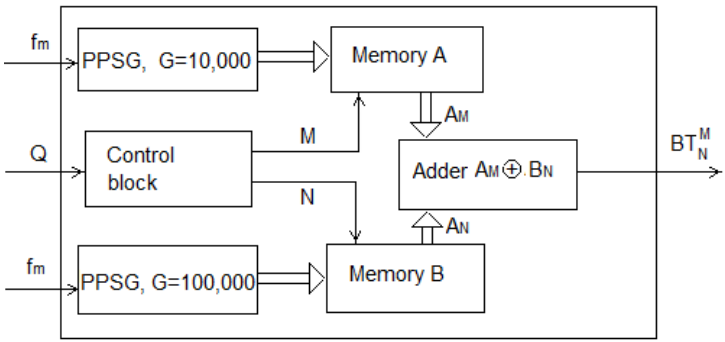
t is the time of tem- i